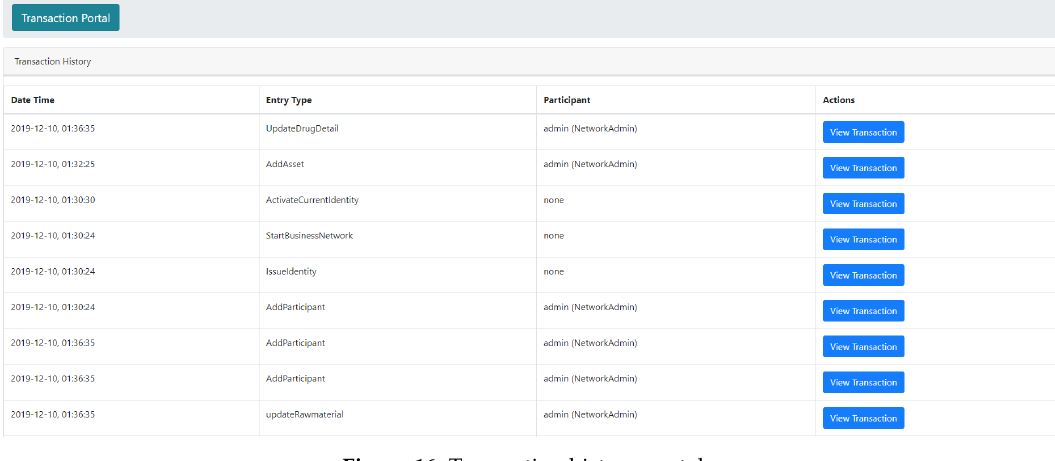
Figure 16. Transaction history portal.